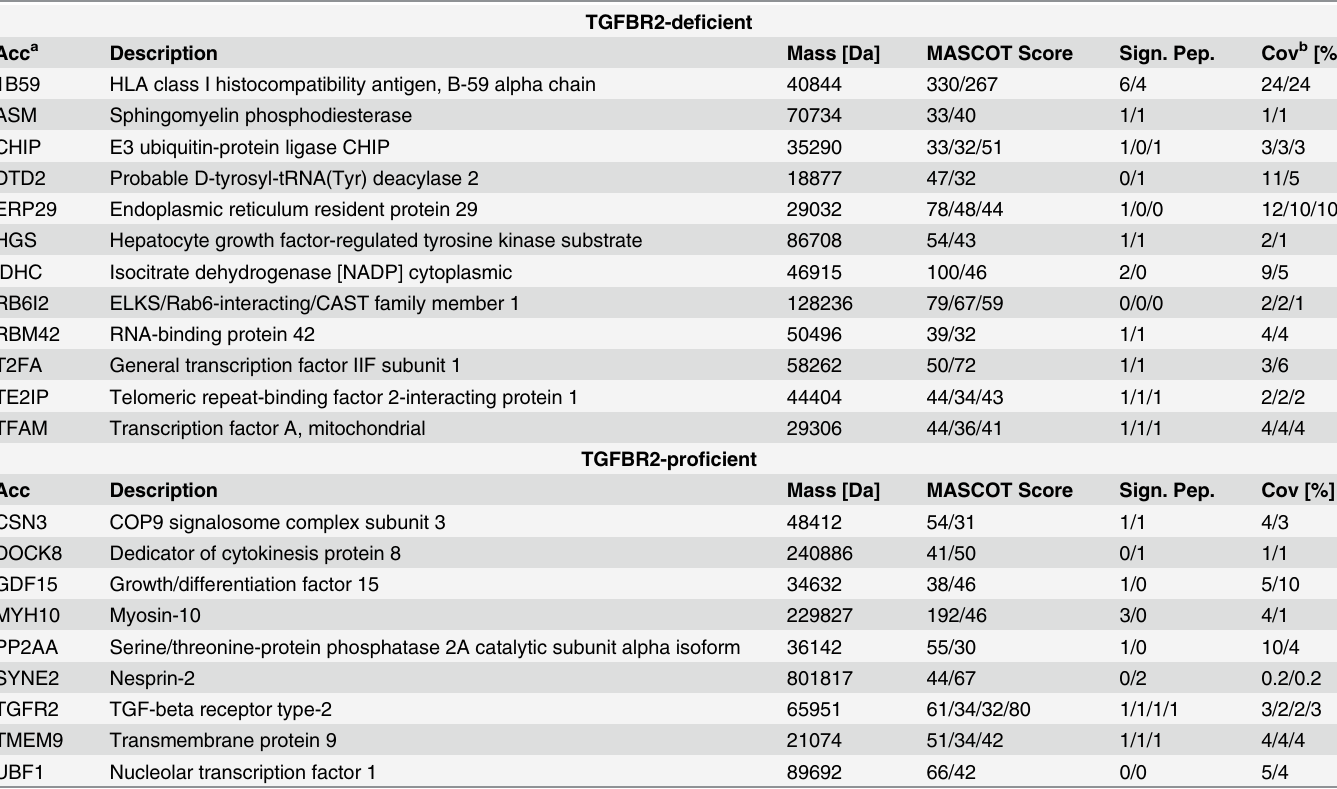
Table 2. Differentially expressed and de novo synthesized proteins in HCT116-TGFBR2 clones #5 and #22 using mass spectrometry.